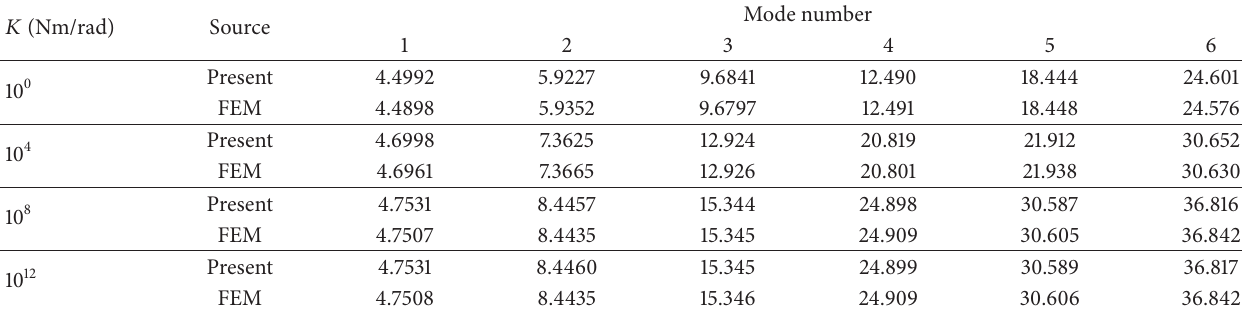
Table 7: Frequency parameters, Ω = 𝜔𝑏 2 (𝜌ℎ/𝐷) 1/2 , for an FCFF annular sector plate with identical elastic restraint at “free” edges ( 𝑎/𝑏 = 0.4, 𝜙 = 𝜋 , and 𝜇 = 0.3